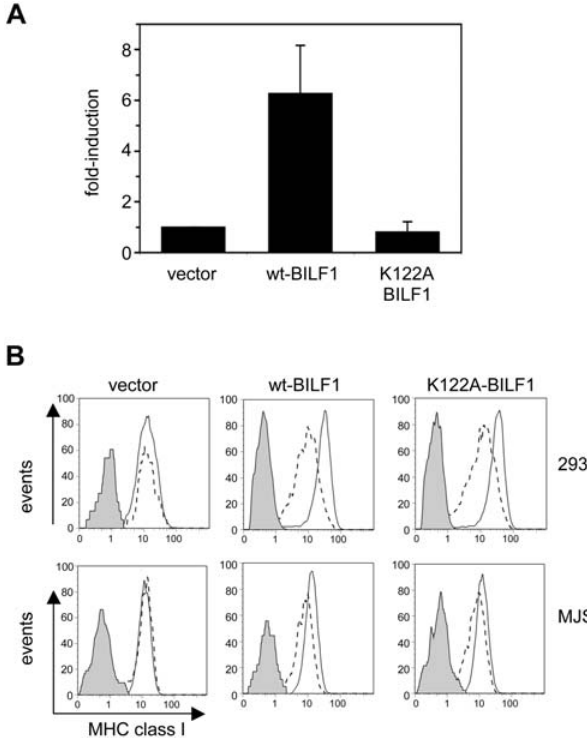
Figure 10. BILF1 signaling function is not required to downregulate MHC class I. ( A ) Wild-type or K122A-mutant BILF1 expression plasmids were transfected into the HEK293-NF k B reporter cell line, and the degree of NF k B activation measured by detection of luciferase activity. The results are the mean 6 S.D. for three independent experiments performed in triplicate. ( B ) 293 and MJS cells were transfected with wild type BILF1 or mutant K122A-BILF1 genes in the bicistronic vector, pCDNA3-IRES-nlsGFP. At 48 hr post-transfection, surface MHC class I molecules were stained and analyzed exactly as in Fig.